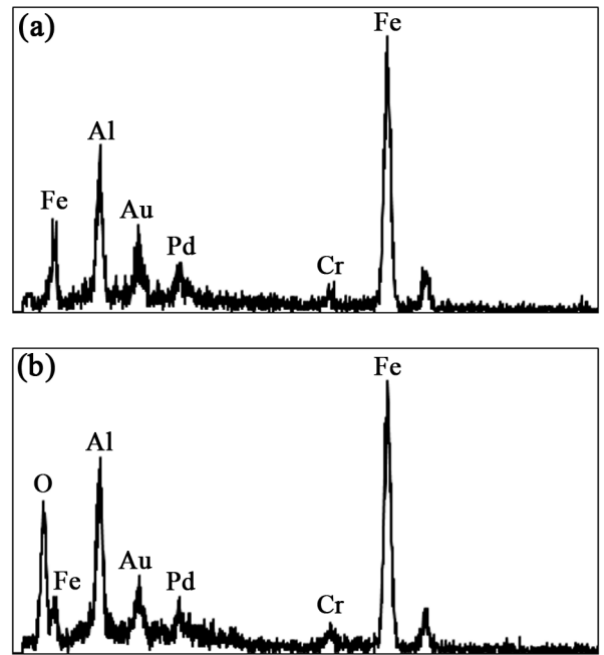
Figure 11. EDS spectra of the worn surface of Fe 3 Al coating at ( a ) 0.04 and ( b ) 0.8 m s − 1 .